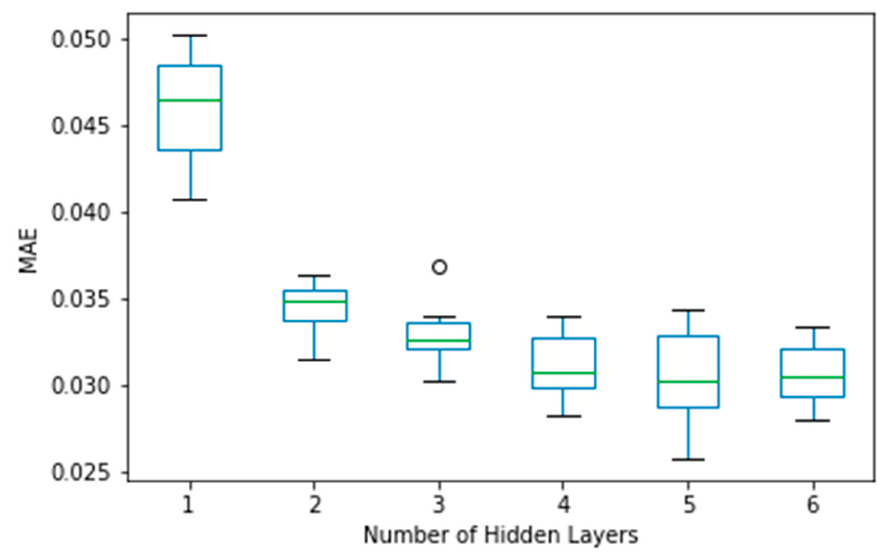
Figure 12. MAE vs. number of hidden layers.